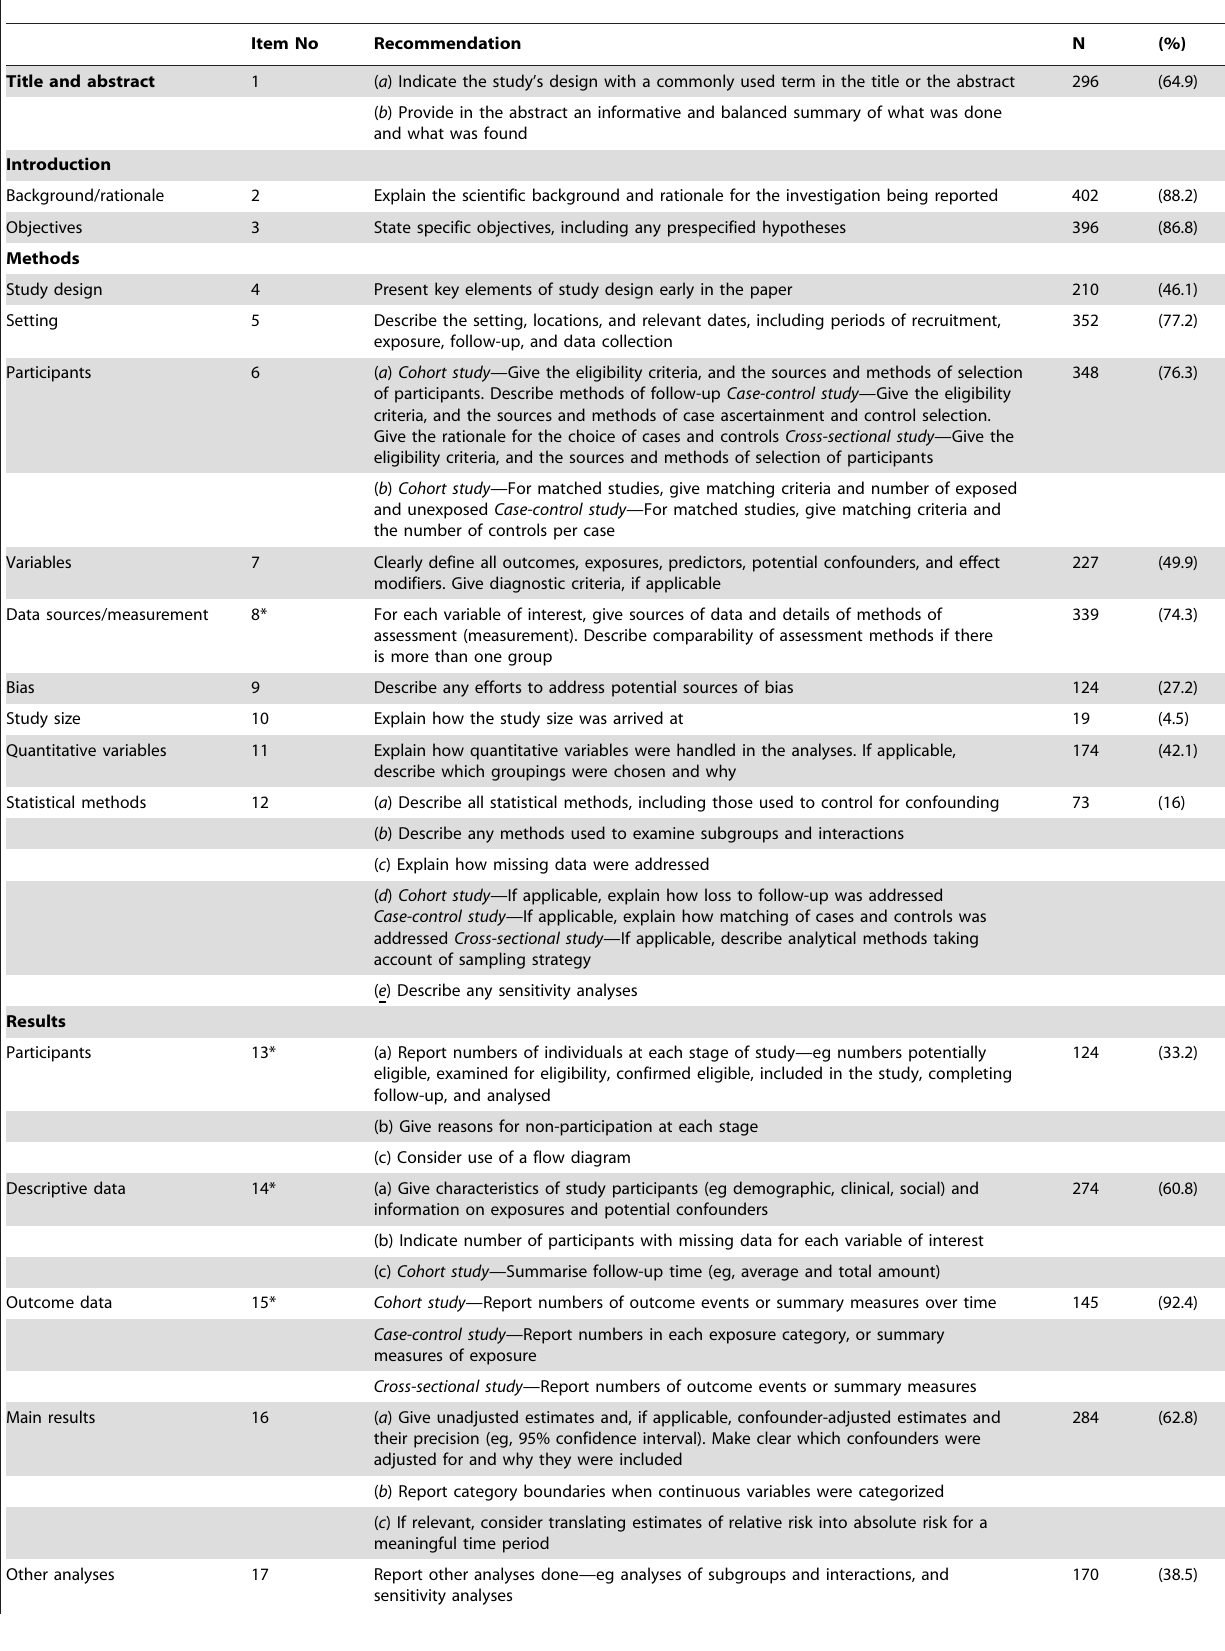
Table 1. Proportion of adequate reporting of the 22 items of the STROBE statement in the 456 articles analyzed.